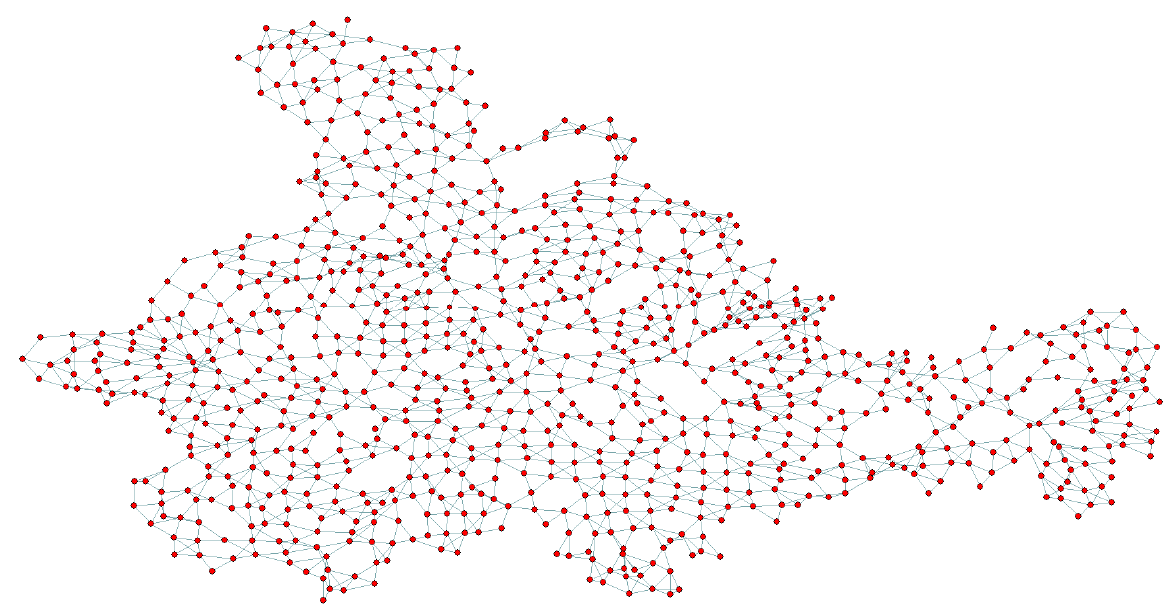
Figure 4. Traffic network in the study area (Source: self-drawn by the author).